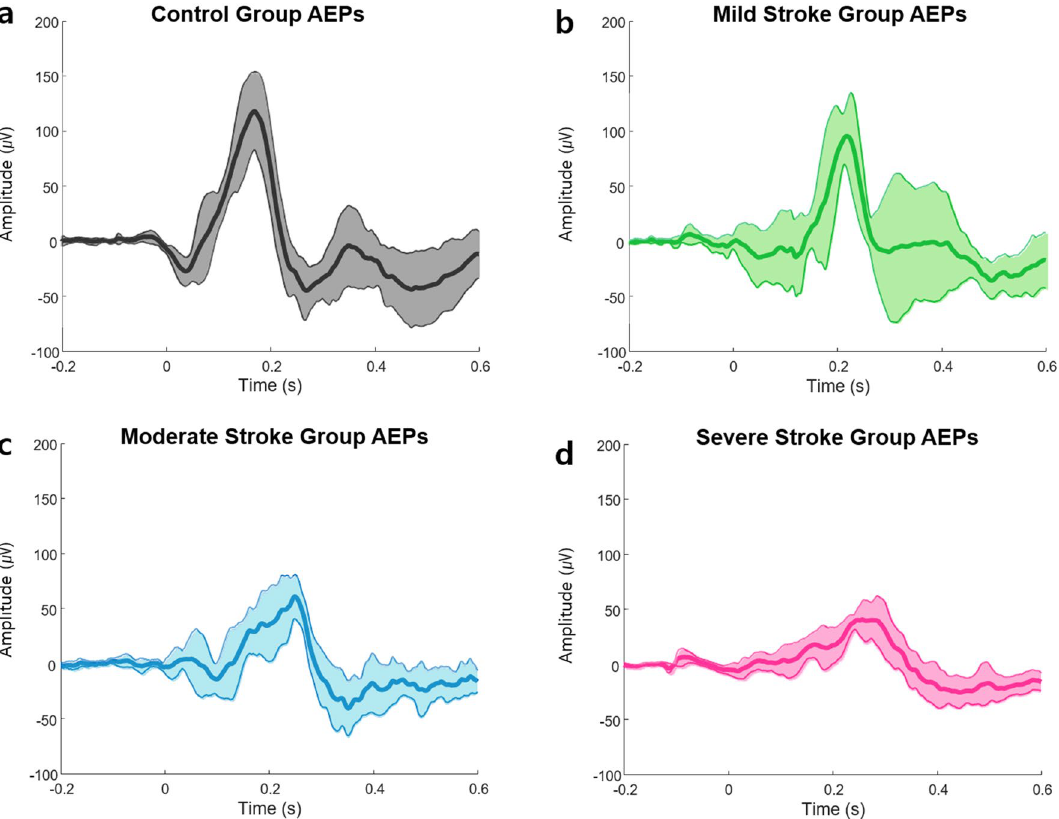
Figure 1. Mean AEPs waveforms of each group. ( a ) Control group, ( b ) Mild stroke group, ( c ) Moderate stroke group, and ( d ) Severe stroke group. The bold lines indicate the mean values, and the shaded bands represent the standard deviations. Note that the peak amplitudes became smaller, and the peak latencies were prolonged as strokes became more severe. AEPs, auditory evoked potentials.